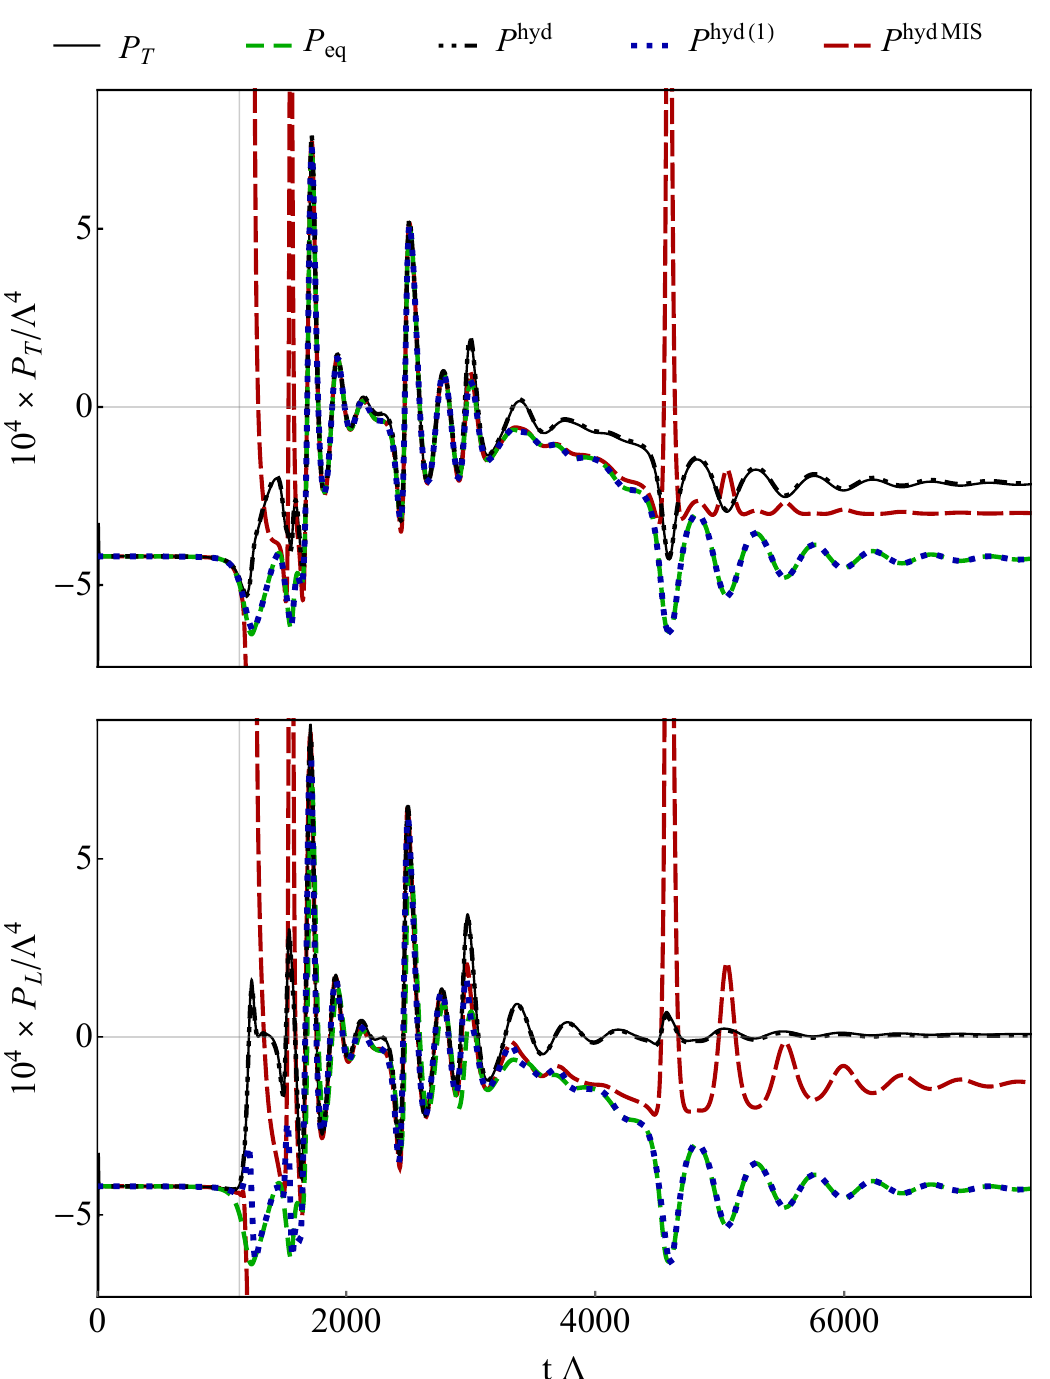
Figure 34 . Time evolution at the point z (cid:3) = 23 of the pressures for the evolution shown in (cid:12)gure 4(left). See the caption of (cid:12)gure 32 for more details. The grey vertical lines indicate the end of the linear regime.